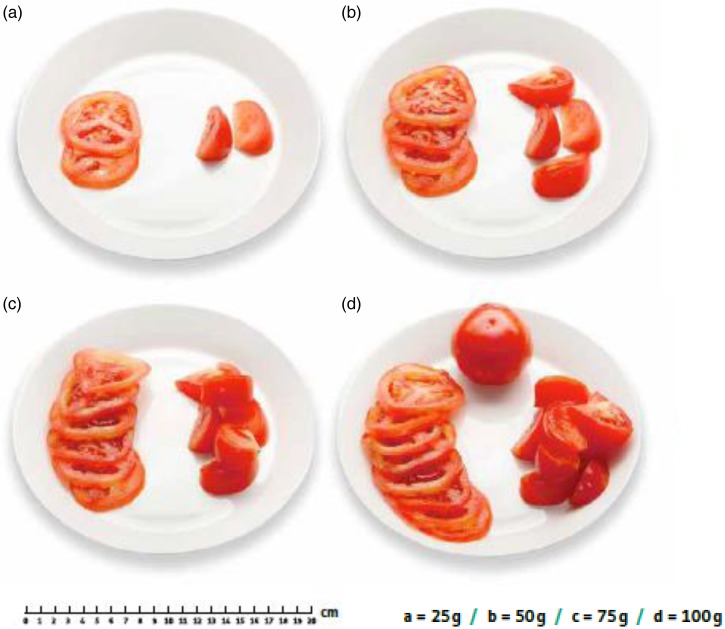
Example of one photograph series of an individual food item (tomato) from the food picture book.